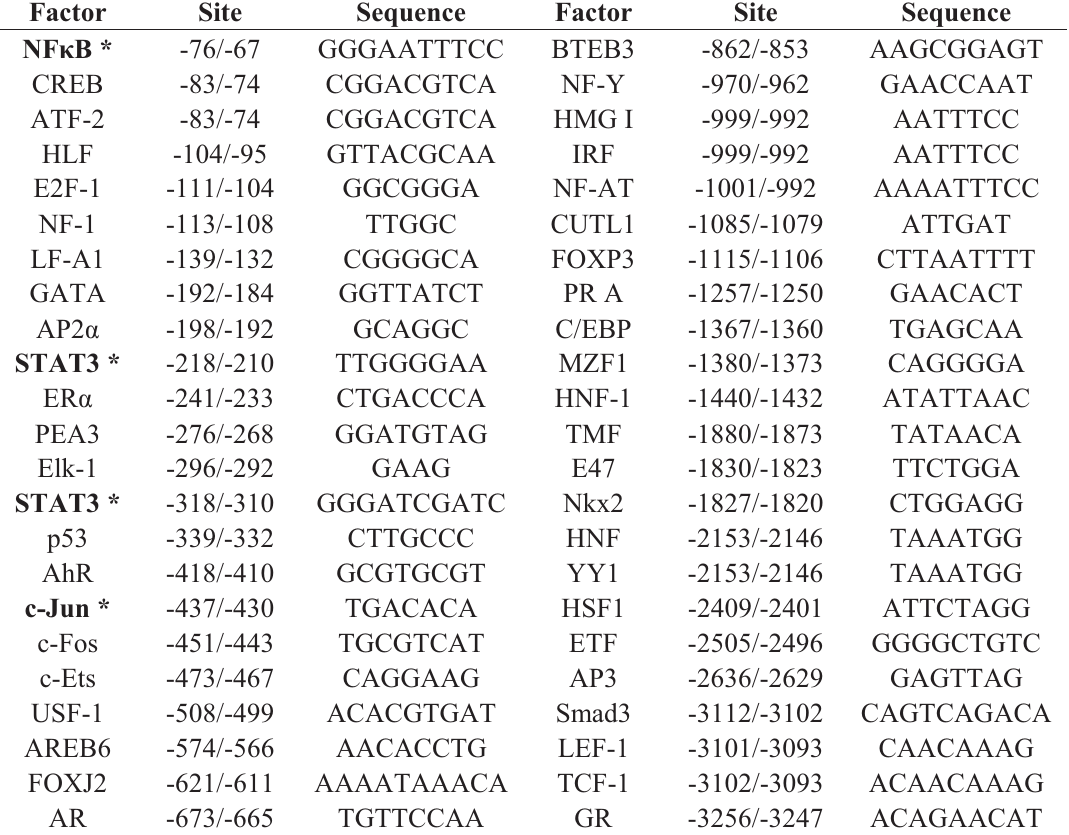
Table 4. List of putative transcription factor binding sites in human CXCL2